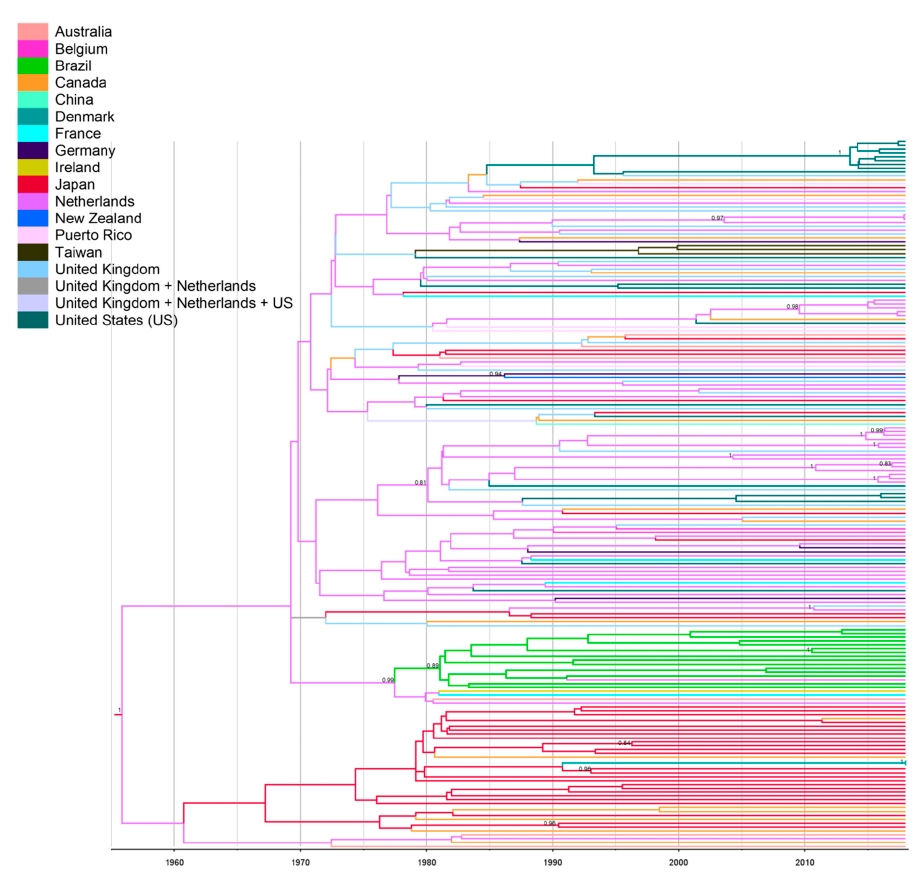
Figure 4. Bayesian maximum clade credibility tree of HCV-2b NS5B sequences. Branches are colored according to the potential locations of the parental node (colored legends in the figure). The scale at the bottom of the tree represents the years before the last sampling time. The numbers on the internal nodes represent posterior probabilities (pp). The tree was automatically rooted under the assumption of a relaxed molecular clock.